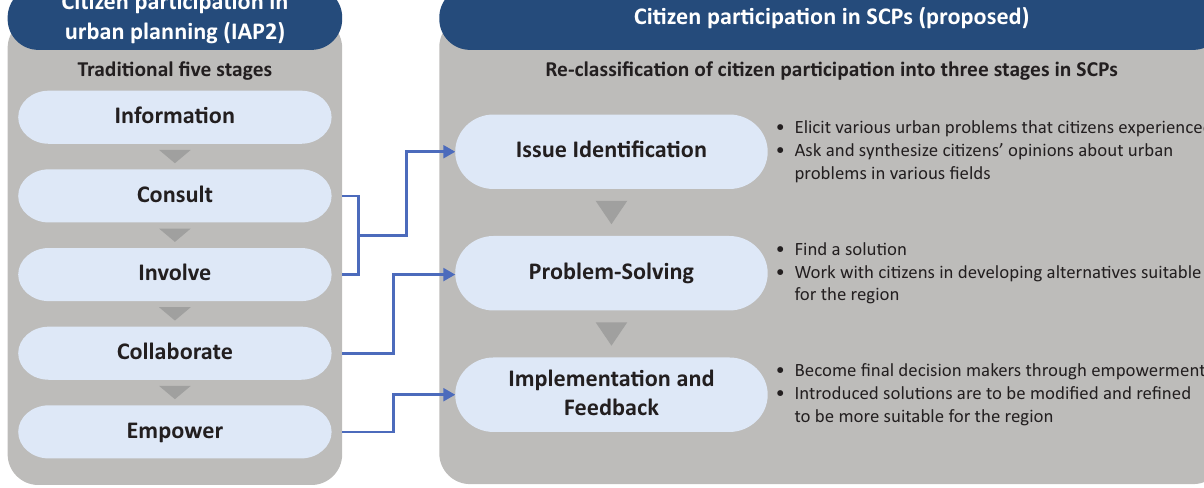
Figure 1. A framework of re‐organization of citizen participation in